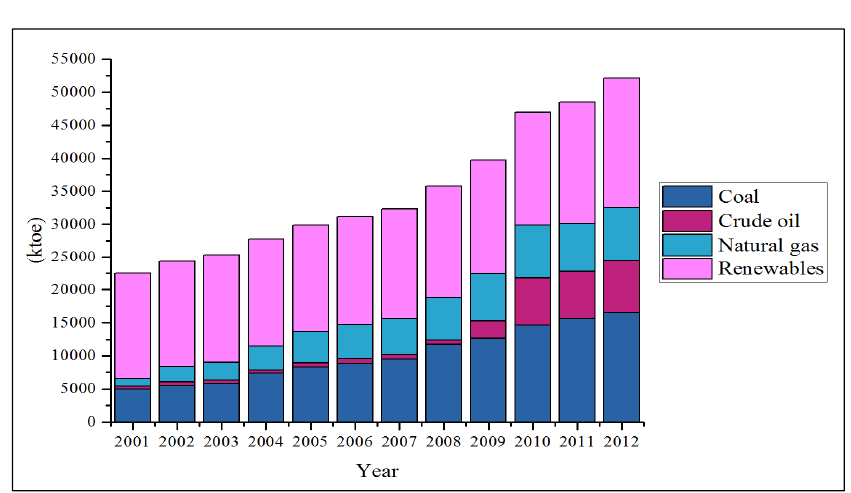
Figure 9. Vietnam: primary energy